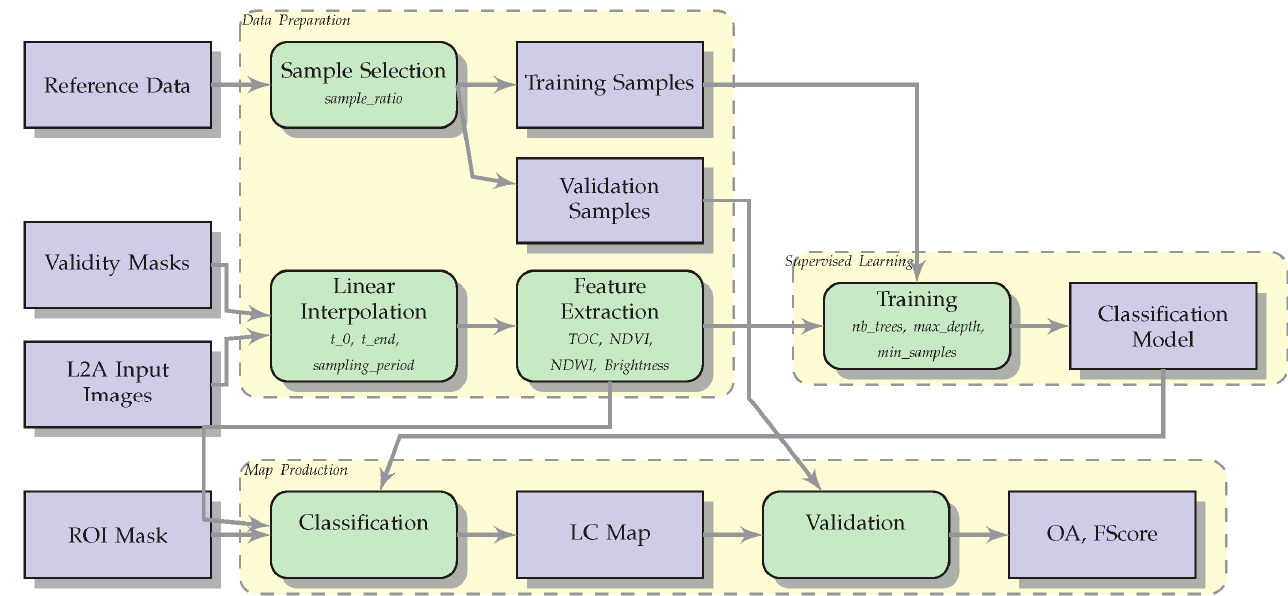
Figure 2. IOTA2 classification module flow chart [18].